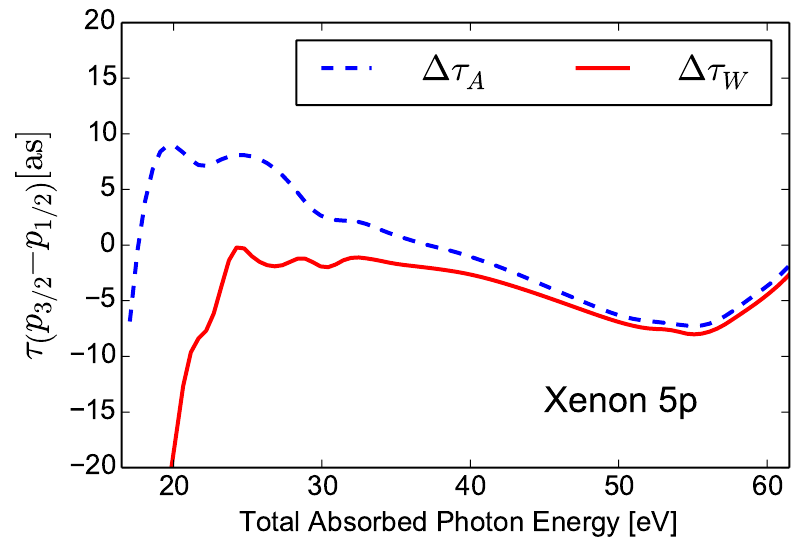
Figure 6. The delay difference between photoelectrons originating from the 5 p 3/2 and 5 p 1/2 orbitals in xenon. The dashed blue line shows the atomic delay, and the solid red the Wigner